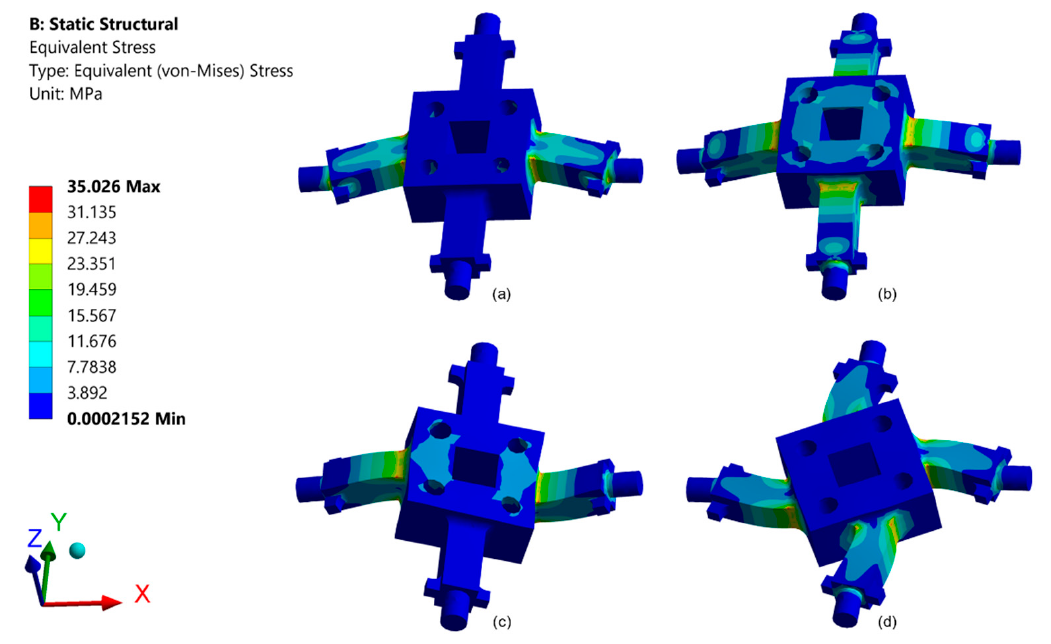
Figure 10. Strain analysis of the elastic body under the applied F/M: ( a ) pure load F x / F y , ( b ) pure load F z , ( c ) pure load M x / M y , ( d ) pure load M z .